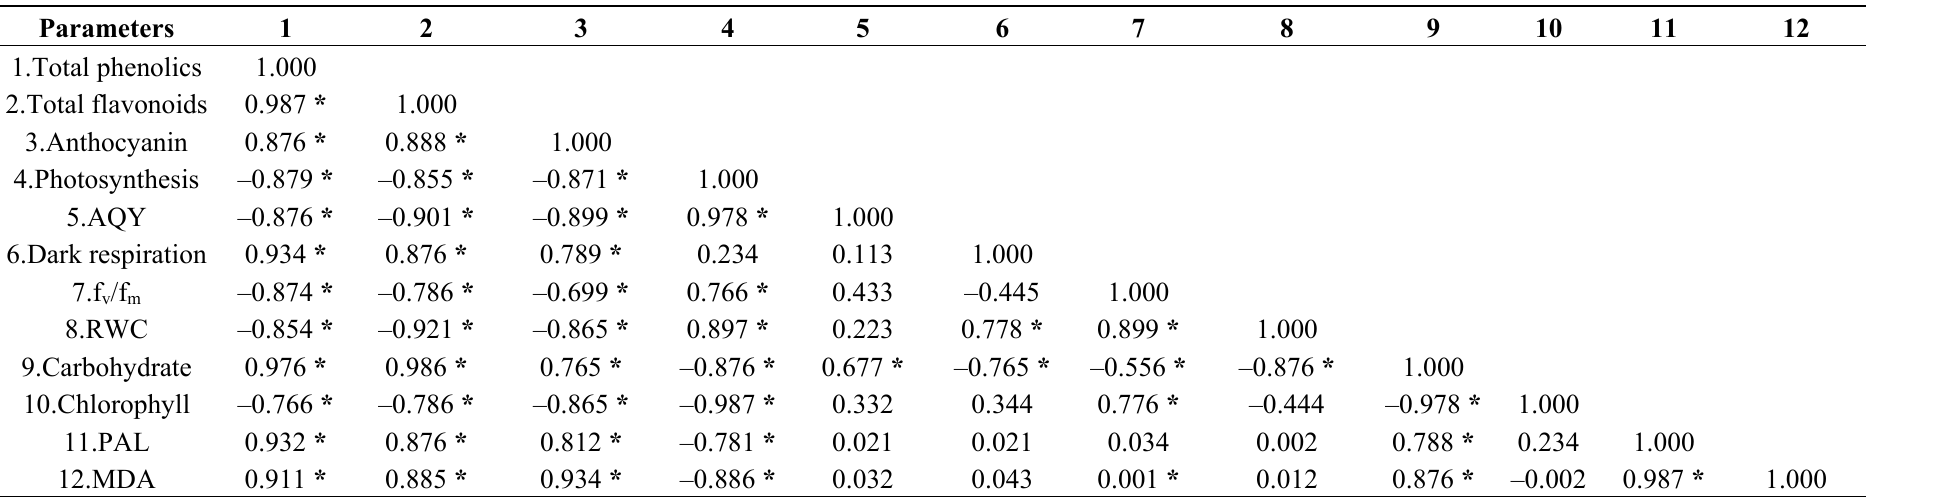
Table 2. Correlations among the measured parameters in the experiments.